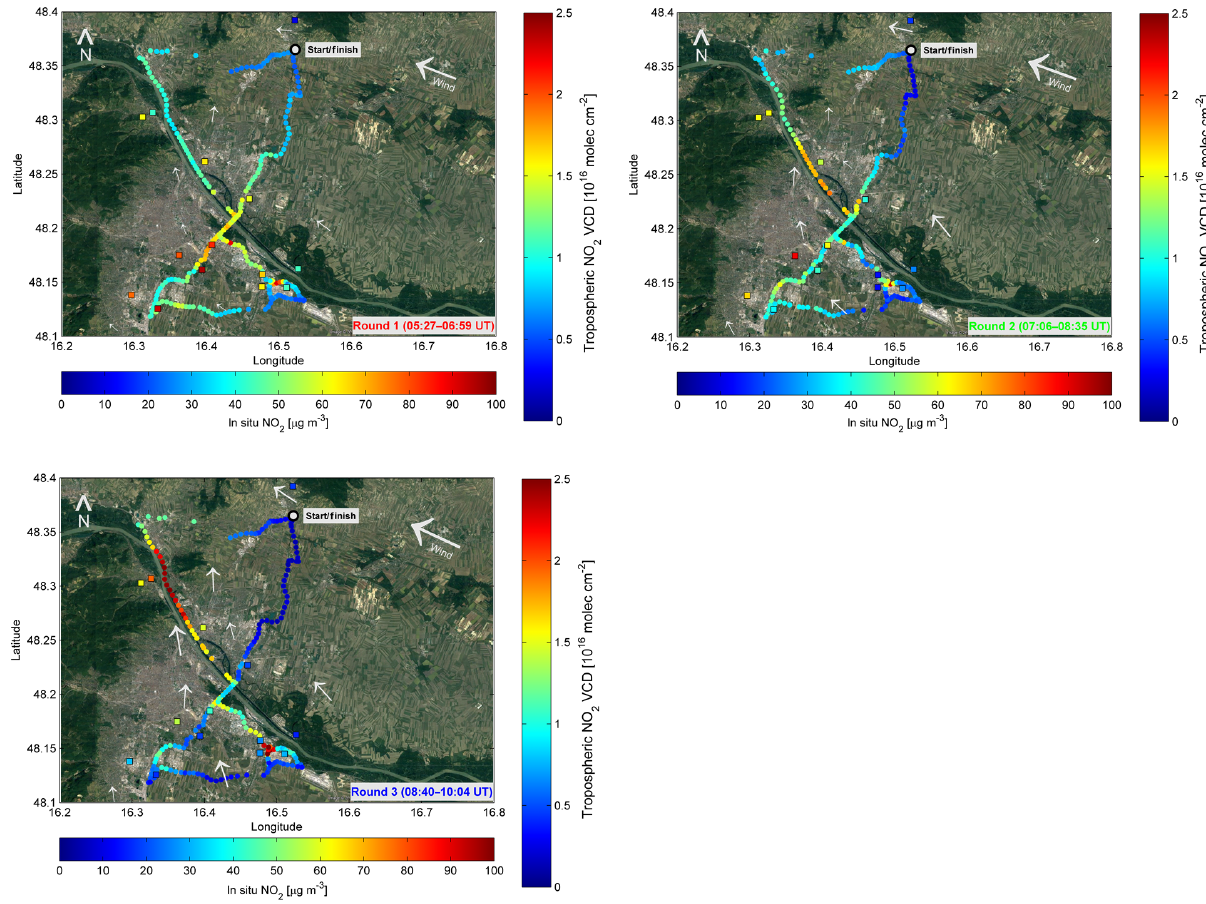
Figure 15. Spatial and temporal evolution of NO 2 on 10 April 2015 in Vienna as measured by the car DOAS zenith-sky (dots) and in situ surface measurements (squares). Wind direction and wind speed obtained from local weather stations are indicated by white arrows. The size of the arrows is weighted by the corresponding averaged wind speed (2m above ground) obtained from the individual weather stations. Averaged wind speeds over the course of the car DOAS zenith-sky measurements taken on this day ranged between 2.28 and 12.81kmh − 1